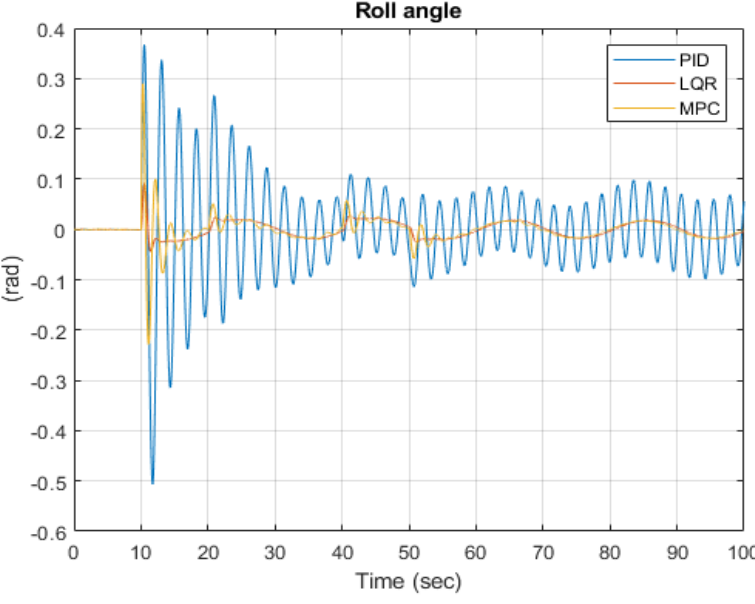
Figure 7. Performance of the controllers in roll angle in simulation.